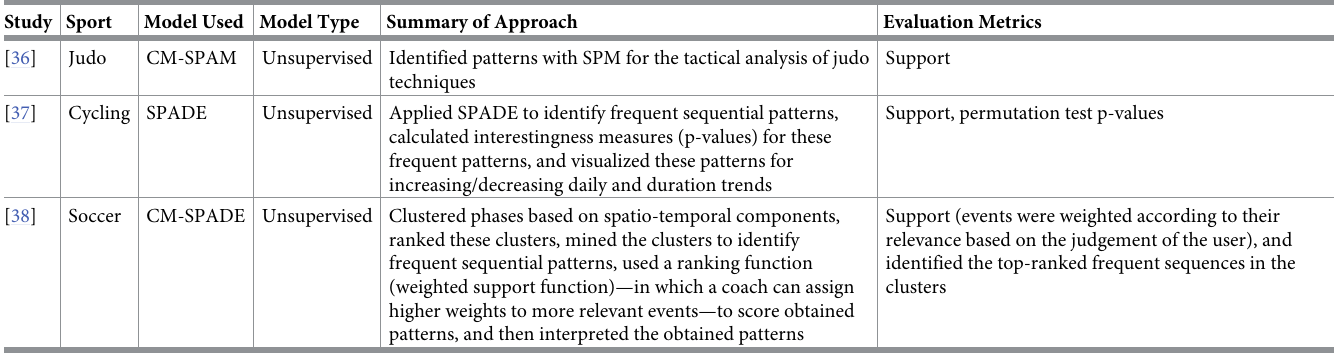
Table 1. Prior studies that have applied sequential pattern mining techniques in